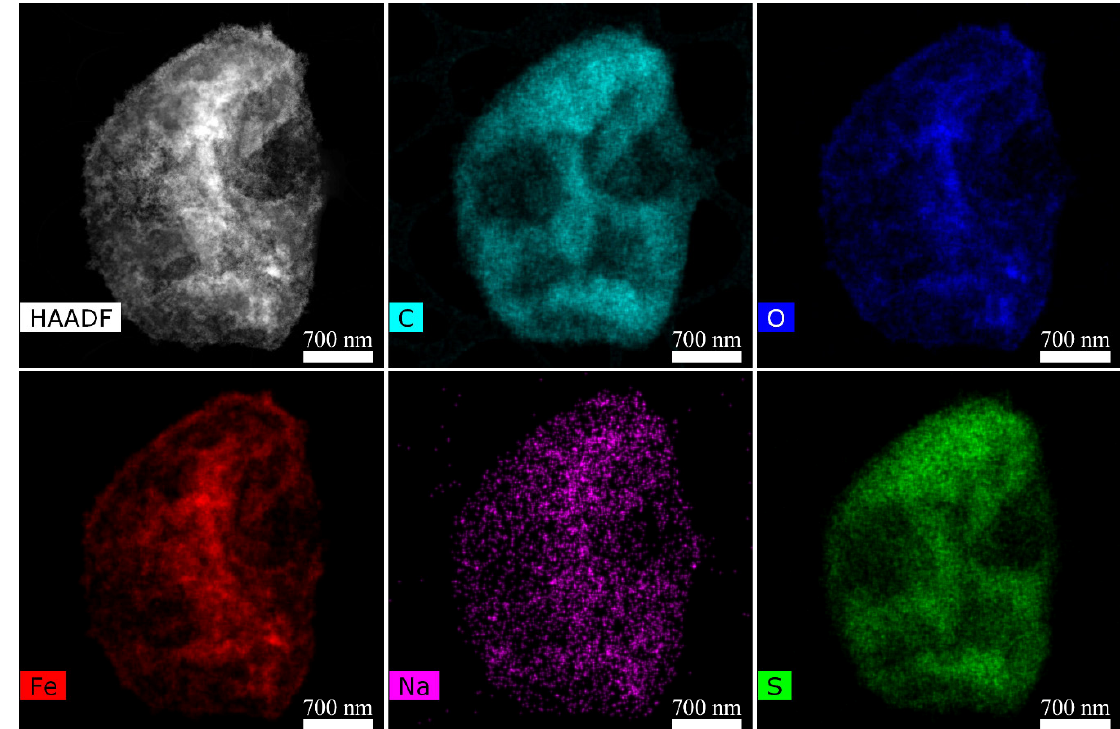
Figure 5. STEM image and elemental mapping of the PAH/PSS/PAH/MNP/PSS/PAH/PSS microcapsule. Table 3. Results of the EDX microanalysis. Table 3. Results of the EDX